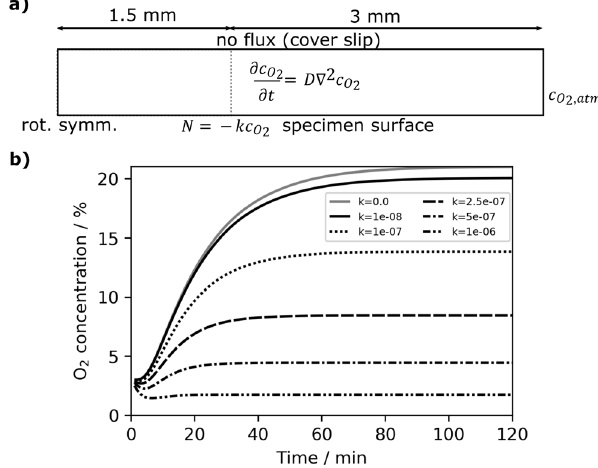
Fig. 4 Schematic and results from computational model of O 2 diffusion and consumption. a Schematic of the rotationally symmetric surface fi lm, in which the diffusion of O 2 from the sample border and its consumption at the Mg alloy surface is modelled. The respective equations and boundary conditions are indicated. The dashed line delineates the radius of the central region that was evaluated for comparison with the experiments. b Model output for different values of the ORR rate k in the central region. The simple diffusion case is shown in